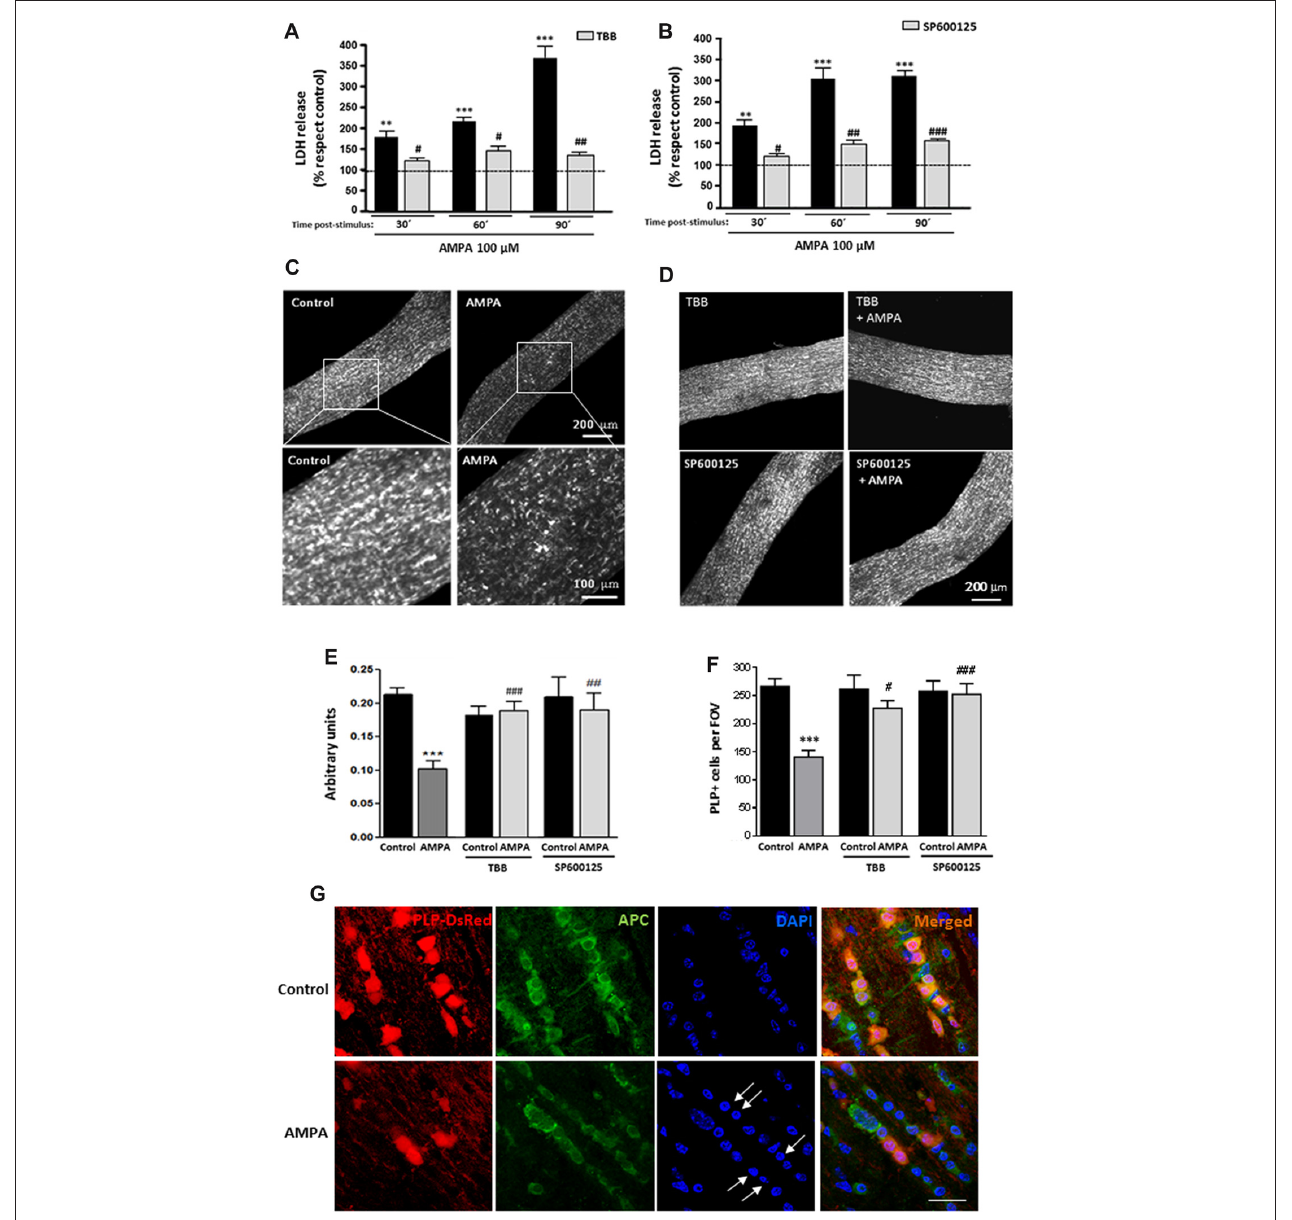
FIGURE 4 | AMPA provokes oligodendroglial damage in isolated optic nerves from PLP-DsRed transgenic mice. Isolated optic nerves from PLP-DsRed transgenic mice were preincubated in artificial CSF medium in absence or presence of TBB (25 µ M; 3 h) or SP600125 (20 µ M; 1 h) and subjected to excitotoxic insult by stimulation of AMPA receptors (100 µ M CTZ plus 100 µ M AMPA) during 2 h. (A,B) Lactate dehydrogenase (LDH) release quantification at 30, 60 and 90 min post-stimulus showed that TBB or SP600125 pre-treated optic nerves exhibited a significant reduction in LDH release at all post-stimulus times analyzed. ∗∗ p < 0.005; ∗∗∗ p < 0.0001 (optic nerves treated with AMPA vs optic nerves control); # p < 0.05; ## p < 0.01; ### p < 0.001 (vs. optic nerves treated only with AMPA). (C,D) Representative fields of z-stacks of optic nerves from PLP-DsRed transgenic mice control or stimulated with AMPA alone (C) or in presence of inhibitors TBB or SP600125 (D) . Note a loss of oligodendrocytes in optic nerves exposed to AMPA, which was prevented by incubation of agonist in presence of TBB or SP600125. (E) Quantification of the fluorescence signal emitted by oligodendrocytes of optic nerves from P25 PLP-DsRed mice, expressed as arbitrary units of fluorescence. ∗∗∗ p < 0.001 (optic nerves treated with AMPA vs. optic nerves control); ## p < 0.01, ### p < 0.001 (vs. optic nerves treated only with AMPA). (F) Cell counts of PLP+ oligodendrocytes were performed and data were represented as mean number of cells ( ± SEM, n > 4 animals) in a constant volume (FOV), as detailed in “Materials and Methods” section. ∗∗∗ p < 0.001 (optic nerves treated with AMPA vs. optic nerves control); # p < 0.05, ### p < 0.001 (vs. optic nerves treated only with AMPA). Both quantifications show that oligodendrocyte loss induced by AMPA excitotoxic insult was inhibited by the presence of TBB or SP600125 inhibitors. (G) Optic nerves from PLP-DsRed transgenic mice were processed for immunofluorescence using antibodies to APC and nuclei were stained with DAPI. Treatment with AMPA induced a dramatic fluorescence loss in both PLP and APC oligodendroglial markers, indicating severe oligodendrocyte damage. In addition, DAPI labeling revealed nuclei condenzation in AMPA-treated optic nerves (arrows). Scale bar 20 µ m.